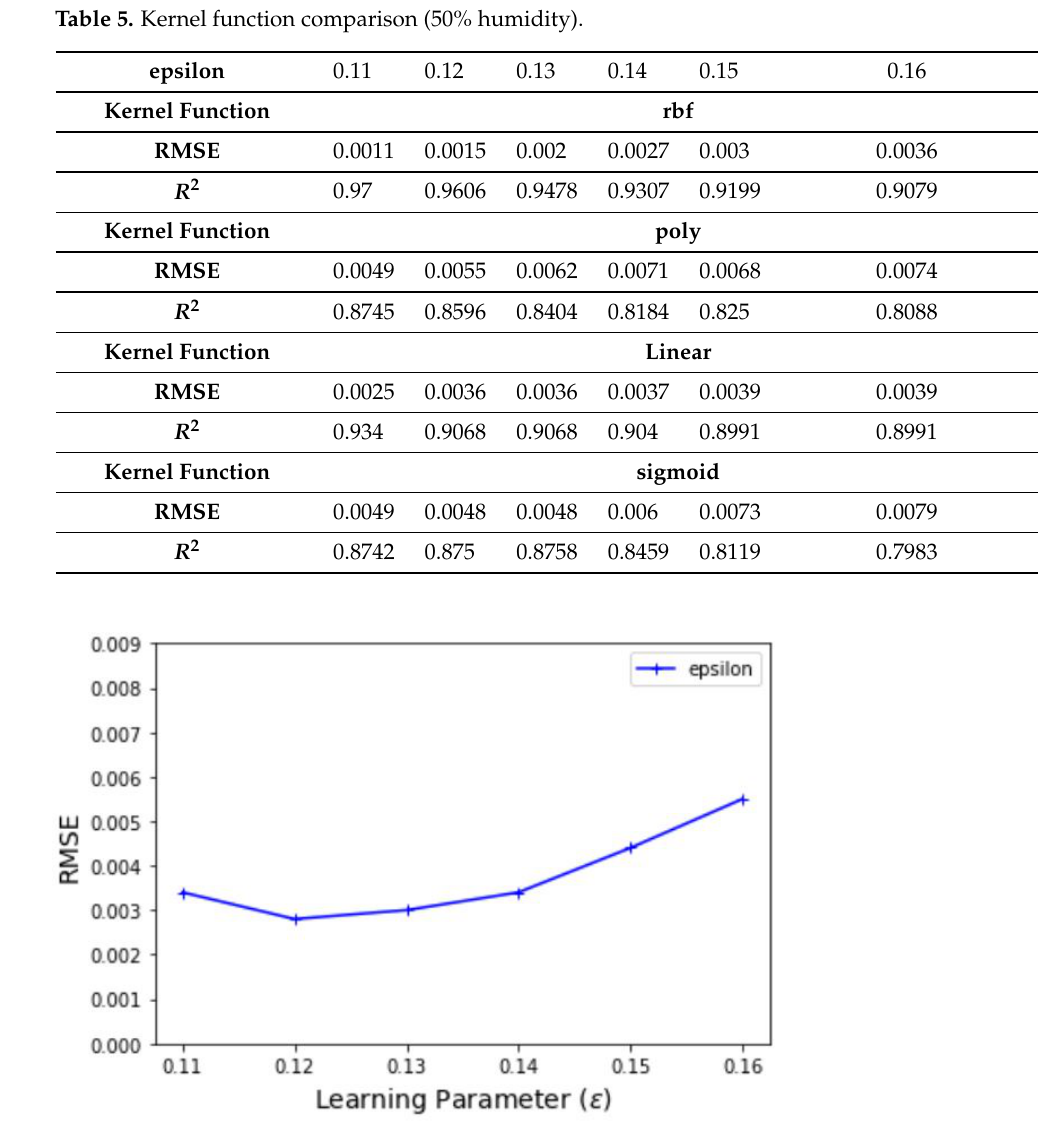
Figure 3. Learning parameter